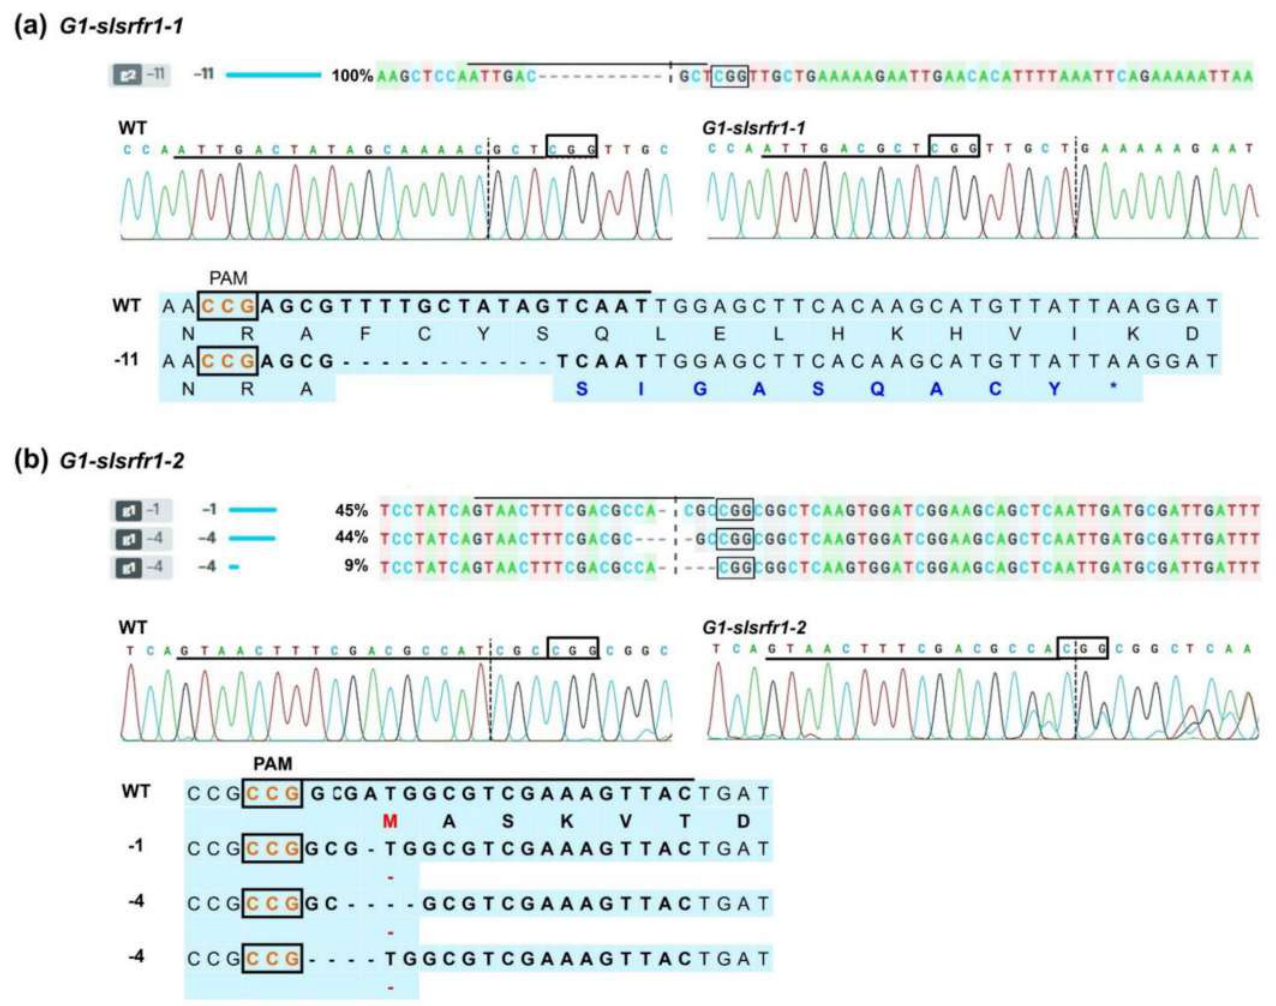
Figure 5. ICE analysis with amplified PCR fragments from slsrfr1 G1 plants, Sanger sequencing chromatograms in target sequence, and predicted amino acid sequences in two homozygous G1-slsrfr1 plants. ( a ) Eleven nucleotide deletions in slsrfr1-1 produces a premature stop codon, colored with blue; ( b ) 1 or 4 nucleotide deletions in slsrfr1-2 remove a start codon (M), colored with red. Nucleotide deletions are indicated by dashes (-). The PAM sites are boxed, and the target sequences of guide RNAs are